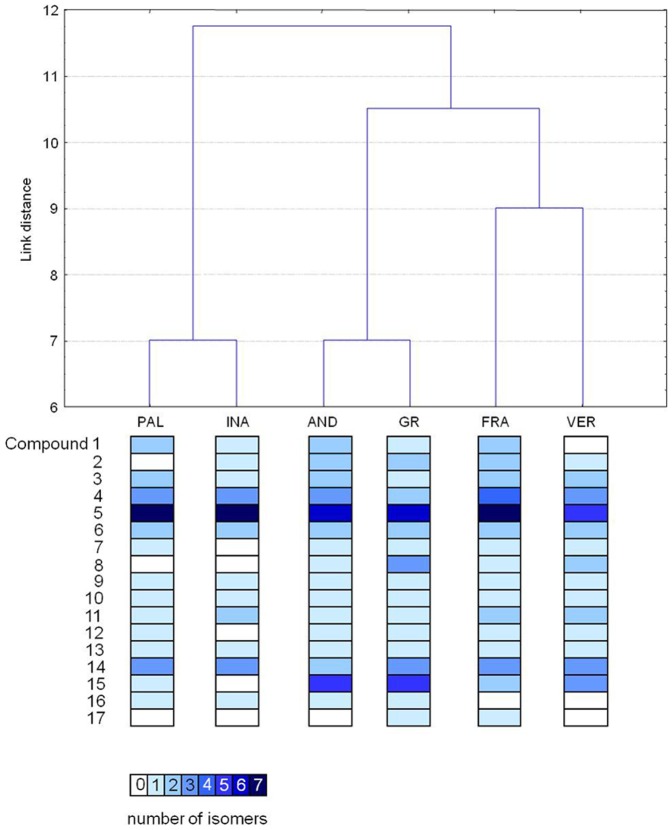
Dendrogram of hierarchical cluster analysis of wheat phenolic composition based on Manhattan similarity distance.For each wheat cultivar, compounds as listed in Table 1 were ordered in columns from the top (compound 1) to the bottom (compound 17). Color intensity, from white to dark blue, indicates the relative abundance of each compound.